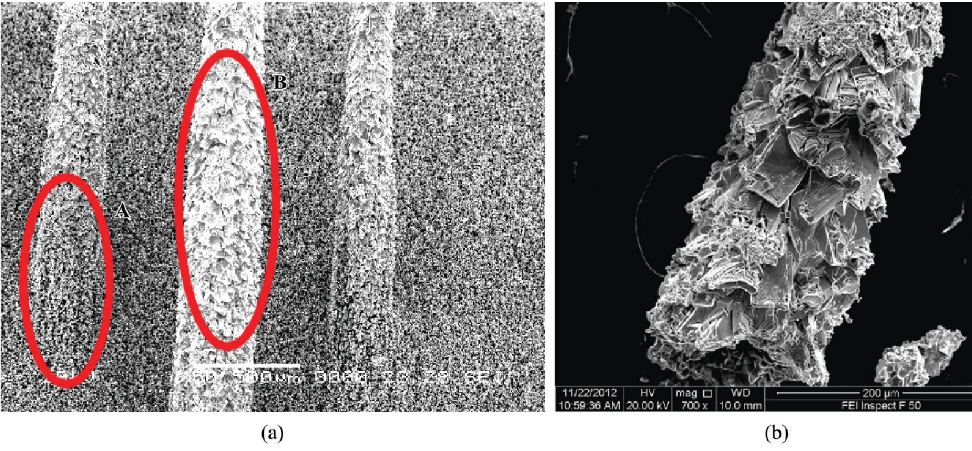
Figure 5. SEM images of (a) needles and (b) magnification of region B.